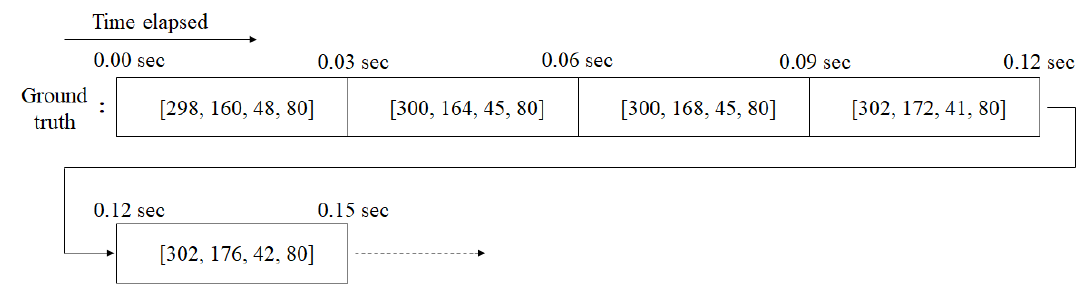
Figure 8. Time based ground